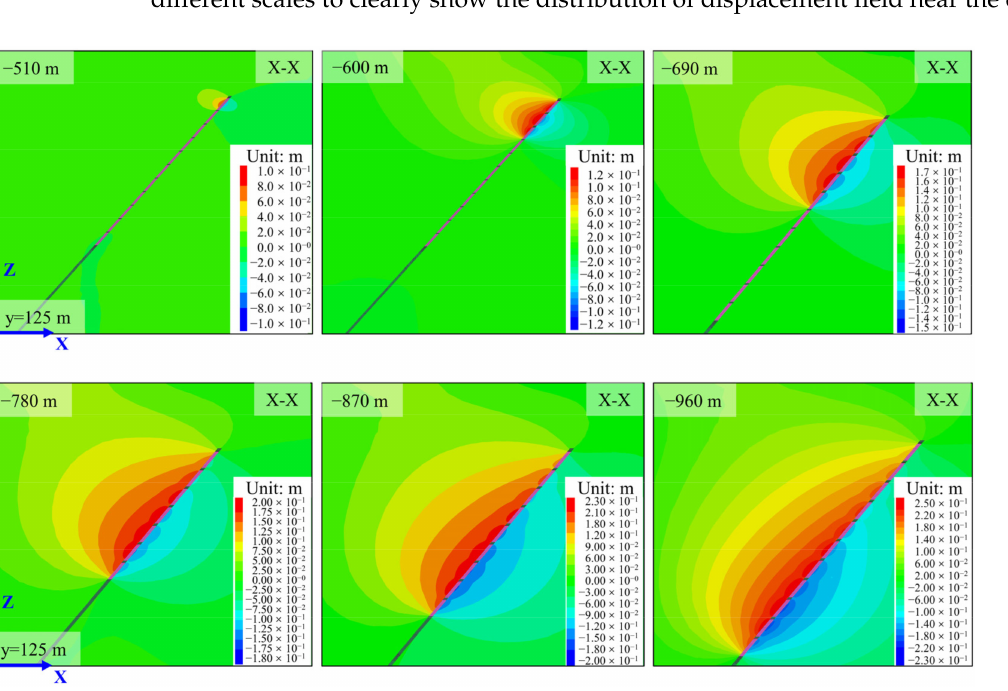
Figure 4. Horizontal displacement of ground at different depths of mining.